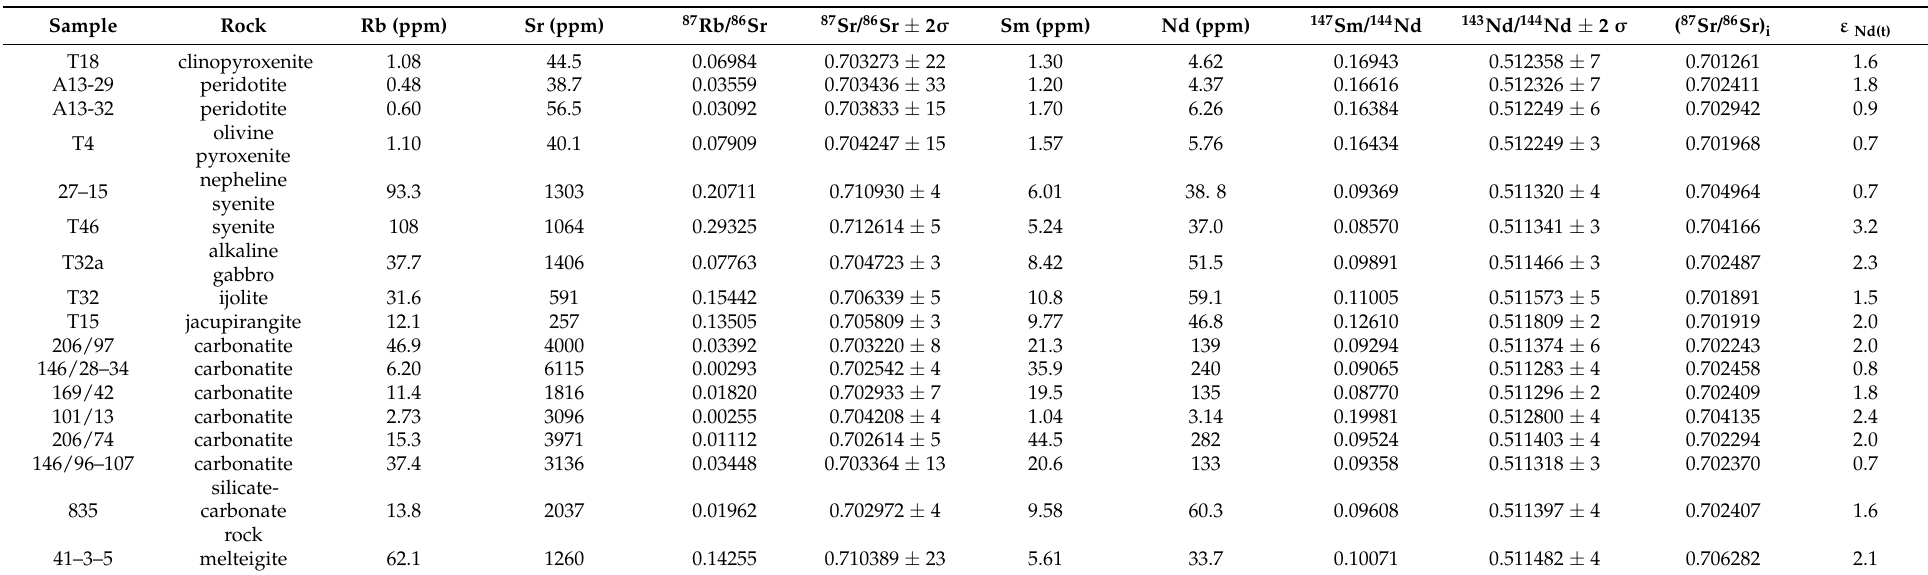
Table 2. Whole rock Rb-Sr and Sm-Nd isotopic data for the Tiksheozero complex.